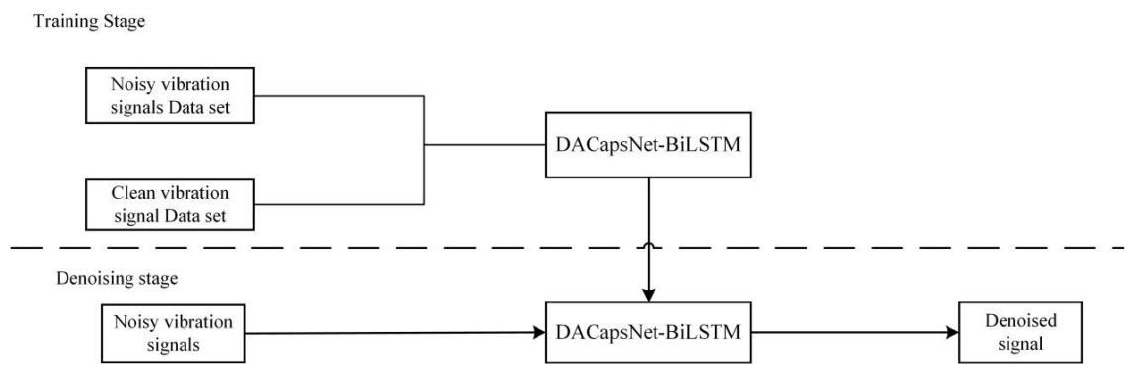
Figure 10. Network training and denoising process.